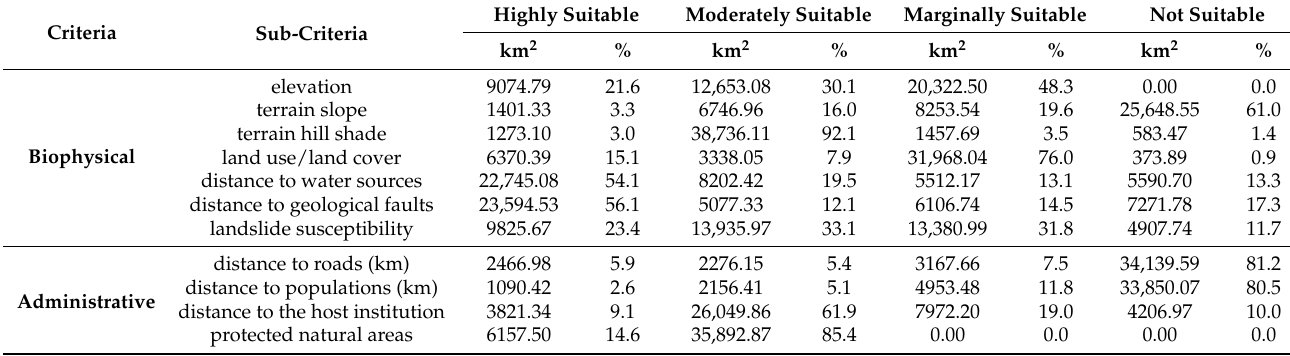
Table 5. Suitability area for sub-criteria to select weather station sites in Amazonas, NW